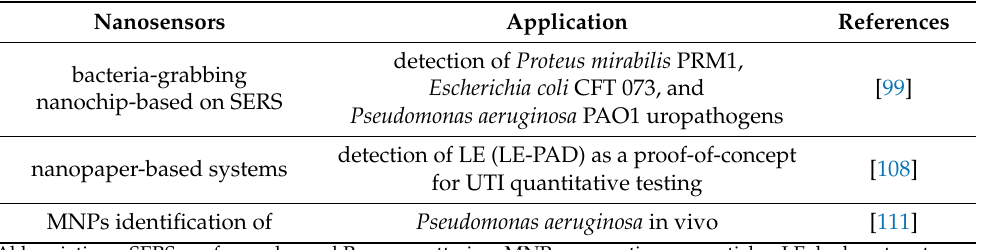
Table 1. Most commonly used nanoparticle (NP)-based sensors for the diagnosis of UTIs.